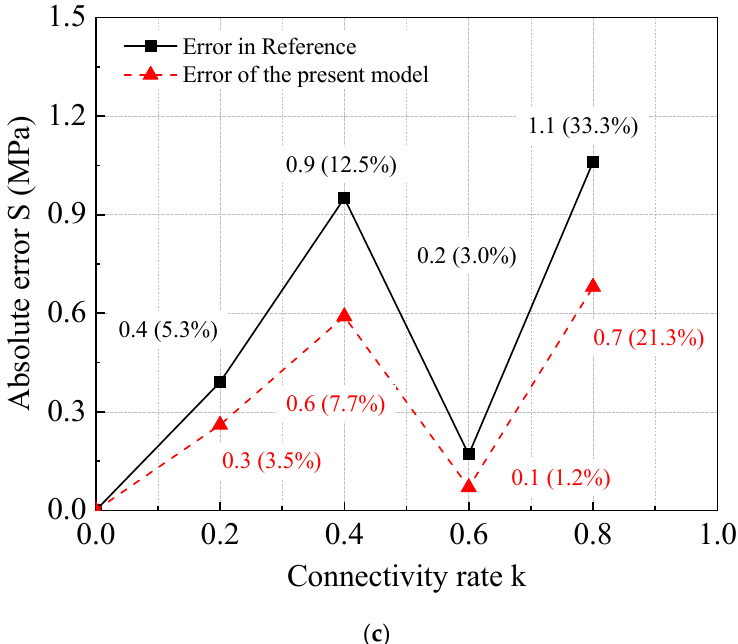
Figure 7. Curves of the Deviation in Peak Strength at Various Joint Inclination Angles. ( a ) α = 15°. ( b ) α = 45°. ( c ) α = 75°.